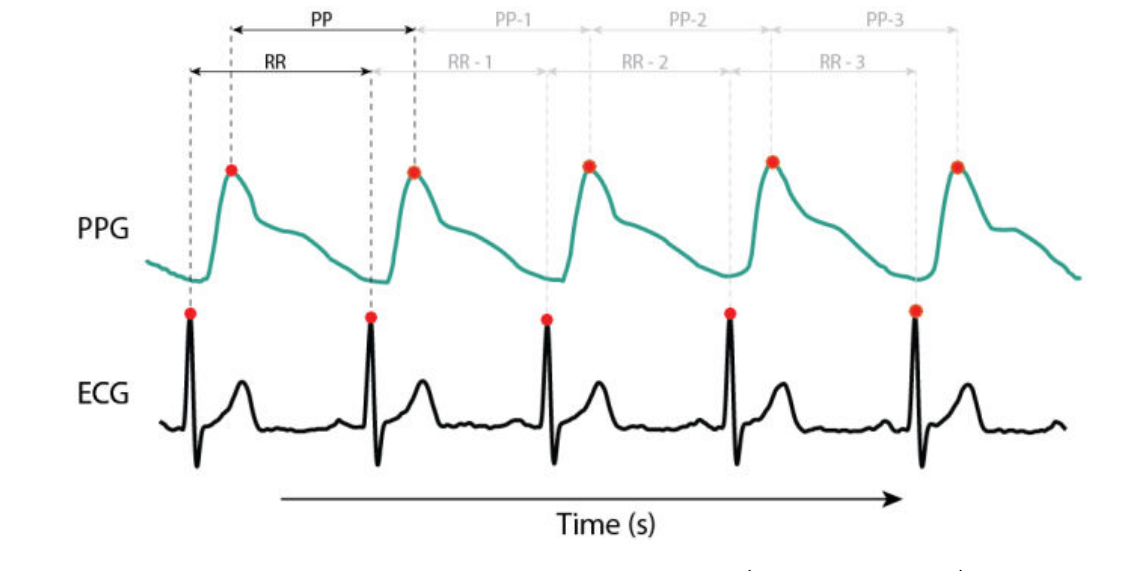
Figure 3. Beat-to-beat analysis from R-R intervals (RRI) and peak-to-peak intervals